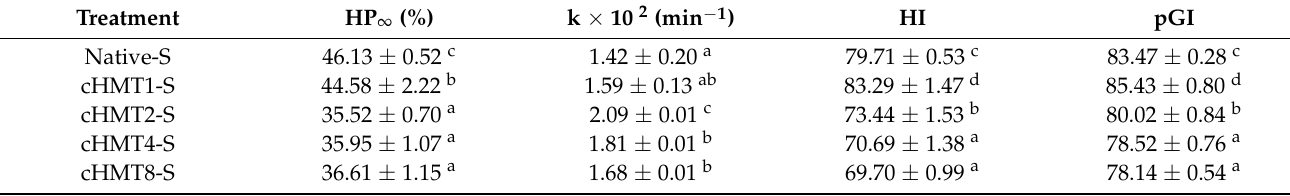
Table 5. The digestibility of native and cHMT water caltrop starch 1,2,3